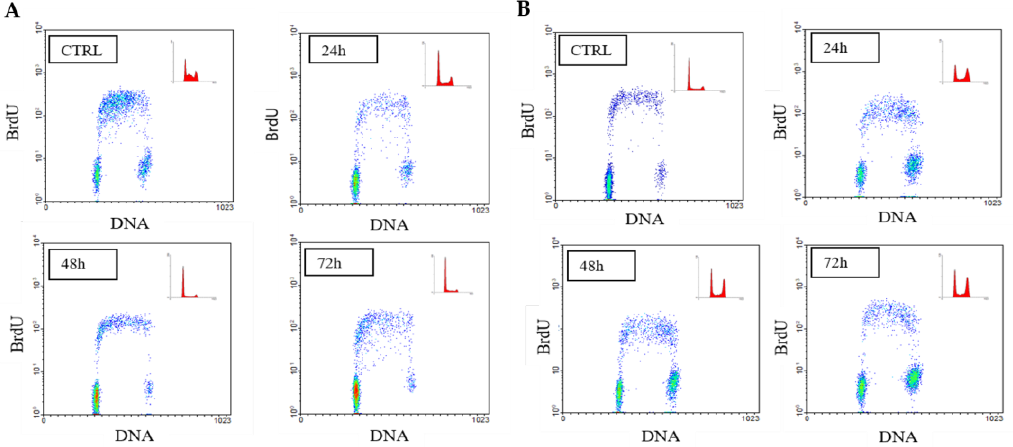
Figure 3. ( A ) Bivariate analysis of bromodeoxyuridine (BrdUrd) incorporation (ordinate) and DNA content (abscissa) in SK-N-BE cells and ( B ) SK-N-BE(2C) cells treated with 100 µM APE for 24–72 h. The BrdUrd-labelled cell fraction appears dramatically reduced in APE-treated cells in both cell lines. Table 1. ( A ) Percentage of SK-N-BE cells in G1, S and G2 / M phases after 100 µ M APE treatment. The data are the mean ± SEM. p values are also reported (APE-treated cells vs. control). ( B ) Percentage of SK-N-BE(2C) cells in G1, S, G2 / M phases after 100 µ M APE treatment. The data are the mean ± SEM. p values are also reported (APE-treated cells vs. respective control).